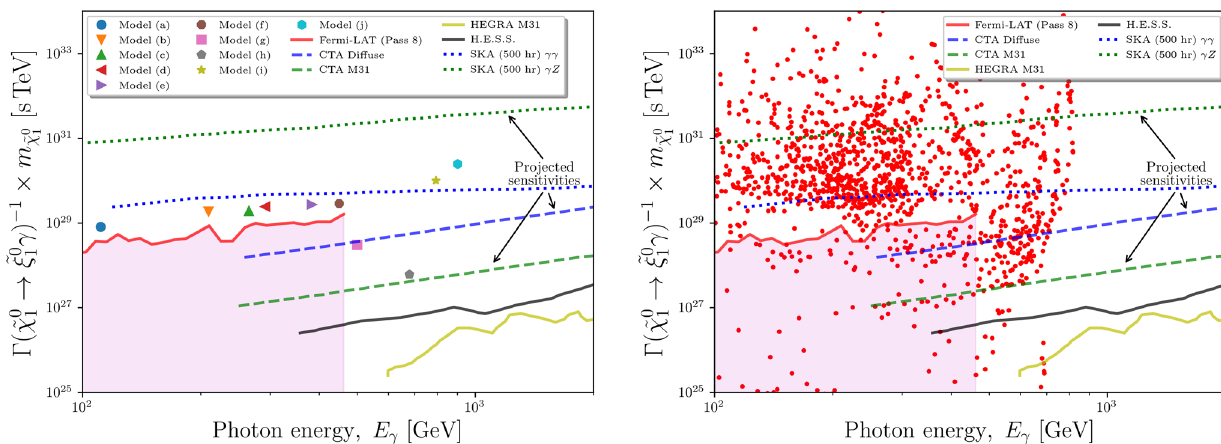
/(cid:18)( ˜ χ 0 → ˜ ξ 0 γ) , in TeV s, versus the Fig. 4 Left panel: a plot of m ˜ χ 0 significant part of the parameter space will be accessible to more sensi- 1 1 1 tivefutureexperimentssuchasSKAandCTA[36,48].Therangesofthe photon energy in GeV for a set of ten benchmarks consistent with all scanned parameters are: 800 GeV < m 0 < 5 TeV, − 5 < A 0 / m 0 < 5, collider and astrophysical constraints. The model points are accessible 700 GeV < m 1 < 5 . 5 TeV, 400 GeV < m 2 < 4 TeV, 2 TeV < m 3 < in future improved experiments. Right panel: a scatter plot in the same 6 . 5 TeV, 1 < tan β < 50, 500 GeV < M 1 < 5 TeV and m X variables shows that the parameterspace in which a decaying neutralino TeV. The current and future limits from dark matter indirect detection consistent with all the current constraints can reside is quite large and a experiments are shown in both